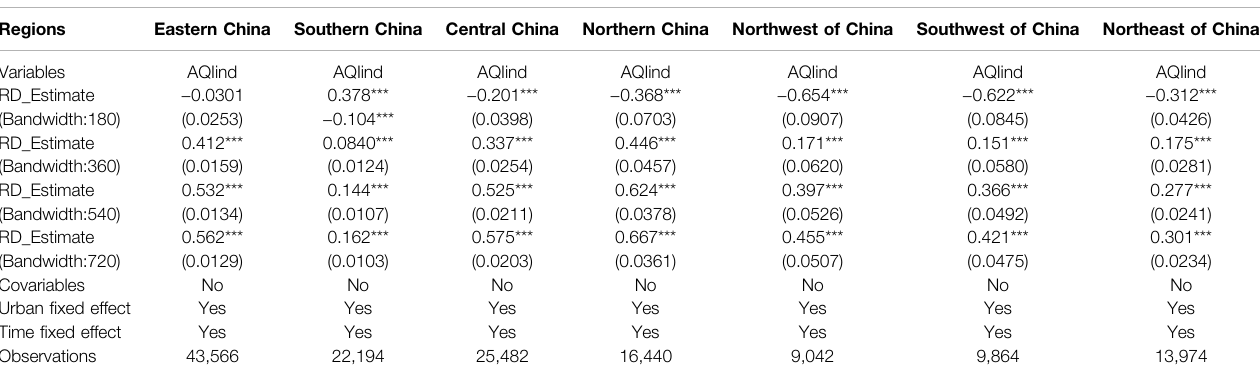
TABLE 10 | Persistence analysis for the seven regions of China.